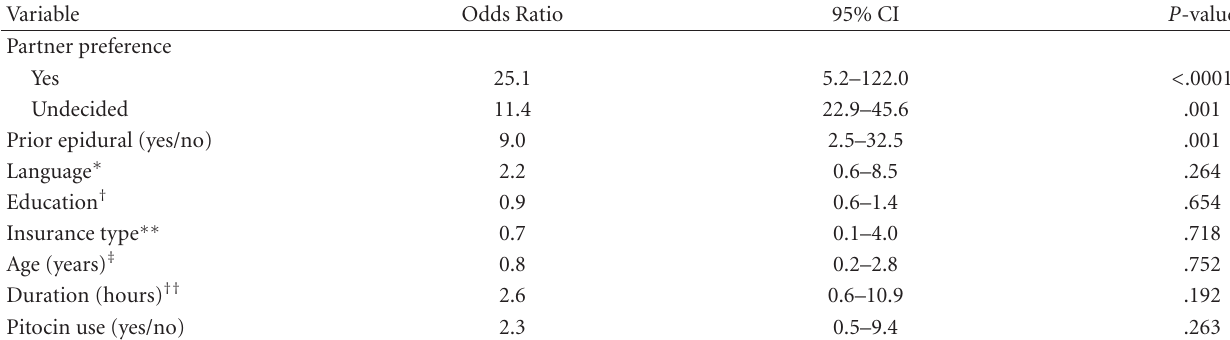
Table 2: Multiple logistic regression analysis of factors associated with patients receiving epidural analgesia during